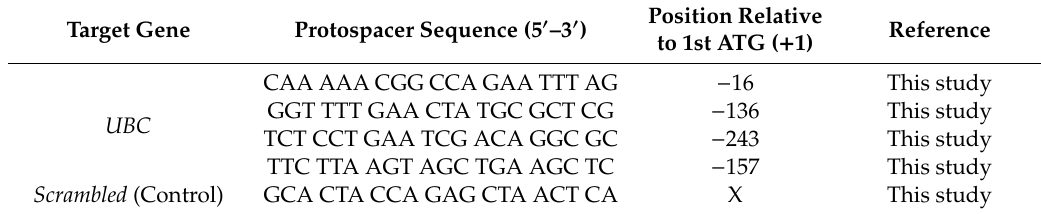
Table 1. sgRNAs used in this